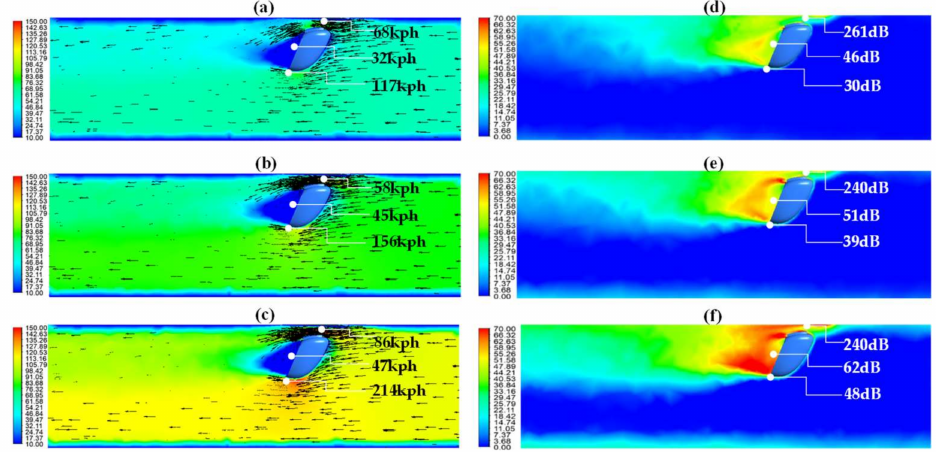
Figure 5. Flow velocity contour with vector field ( a – c ) and maximum sound pressure level ( d – f ) of the second OSRVM model with two inner ducts at 23 ◦ C and 50% humidity conditions for three vehicle speeds: ( a , d ) 60 kph, ( b , e ) 80 kph, and ( c , f ) 110